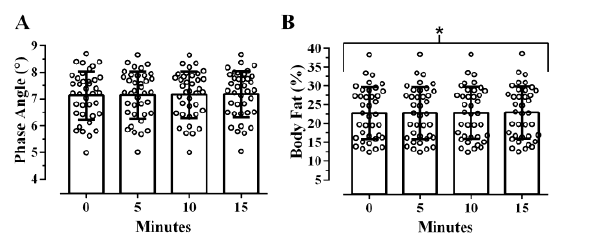
Fig. 3: Effect of time since transitioning from a vertical to a supine position on phase angle (A), and body fat percentage (B) over 15 minutes as assessed via the RJL Quantum Legacy analyzer (N=38). Open circles represent individual responses. *Denotes a statistically significant increase from baseline over the course of 15-minutes resting in a supine position